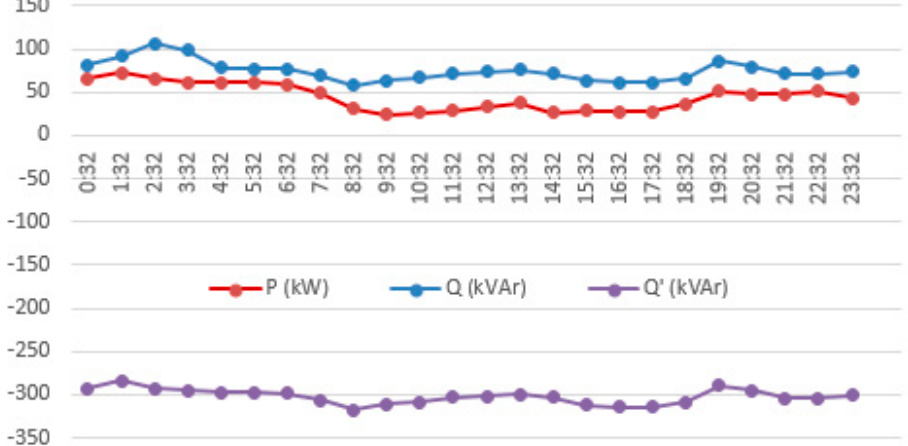
Figure 4. Active ( P ) and reactive ( Q (cid:48) ) powers delivered by the transformer on working days, as well Figure 4. Active ( 𝑃 ) and reactive ( 𝑄′ ) powers delivered by the transformer on working days, as well as the reactive powers ( Q ) supplied without capacitor banks. (Negative sign indicates capacitive as the reactive powers ( 𝑄 ) supplied without capacitor banks. (Negative sign indicates capacitive reactive powers). reactive powers).